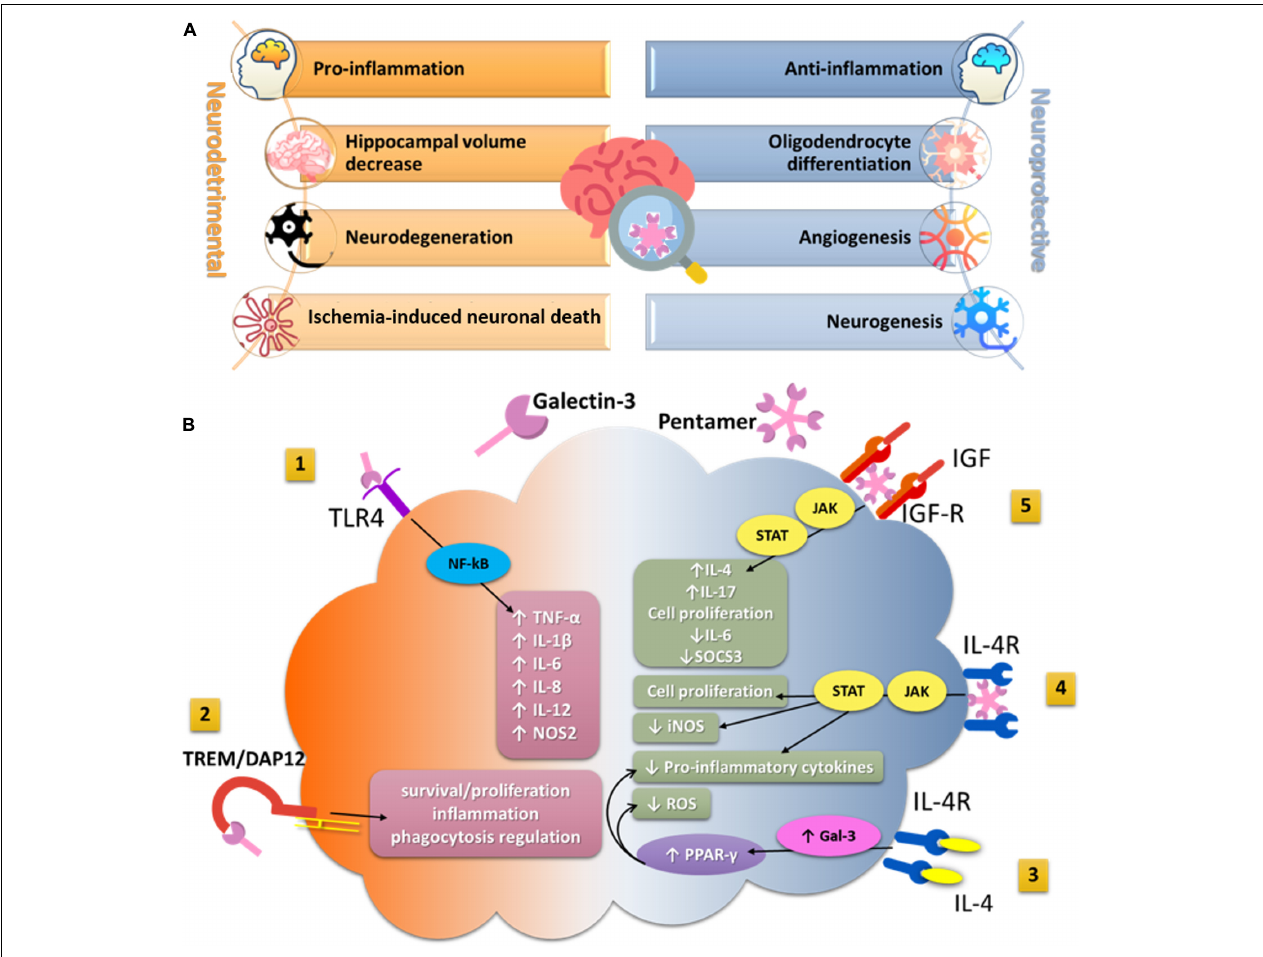
FIGURE 1 | (A) The effects of Gal-3 in hippocampal tissue related to cognitive functioning. (A) Represents the summary of the main neurodetrimental and neuroprotective effects of Gal-3 in hippocampal tissue which potentially impact cognitive functioning. (B) The impact of Gal-3 on microglia functions in a neuroinflammatory context. (1) Secreted Gal-3 directly binds to TLR4 on the microglia surface and exacerbates inflammatory response by enhancing the production and secretion of proinflammatory cytokines and reactive nitrogen species. (2) Acting as a ligand for TREM2, Gal-3 activates TREM2/DAP12 signaling pathway and may further regulate processes of phagocytosis, inflammation, and proliferation. (3) IL-4 can interact with its tyrosine kinase receptor IL4-R on the microglia surface and increase intracellular production of Gal-3 that further activates transcriptional factor PPAR- γ . (4) The lattice formation of Gal-3 induces microglia activation through interaction with the interleukin-4 receptor (IL4R) and activates anti-inflammatory signaling. (5) By crosslinking insulin-like growth factor 1 receptor (IGFR-1), secreted Gal-3 prevents early endocytosis and over-activates the JAK/STAT signaling pathway and the transcription of genes needed for cell proliferation. TLR4, Toll-like receptor4; TREM2, triggering receptor expressed on myeloid cells-2; DAP12, DNAX-activating protein of 12 kDa; PPAR- γ , peroxisome proliferator-activated receptor gamma; IL-4, Interleukin 4; IL-4R, Interleukin-4 receptor; JAK/STAT, Janus kinase/Signal transducer and activator of transcription; iNOS, inducible nitric oxide synthase; NOS2, nitric oxide synthase-2; ROS, reactive oxygen species; IGF, insulin-like growth factor; IGF-R, insulin-like growth factor receptor; NF- κ B, nuclear factor kappa-B; SOCS3, suppressors of cytokines signaling 3; TNF- α , tumor necrosis factor alpha; IL,